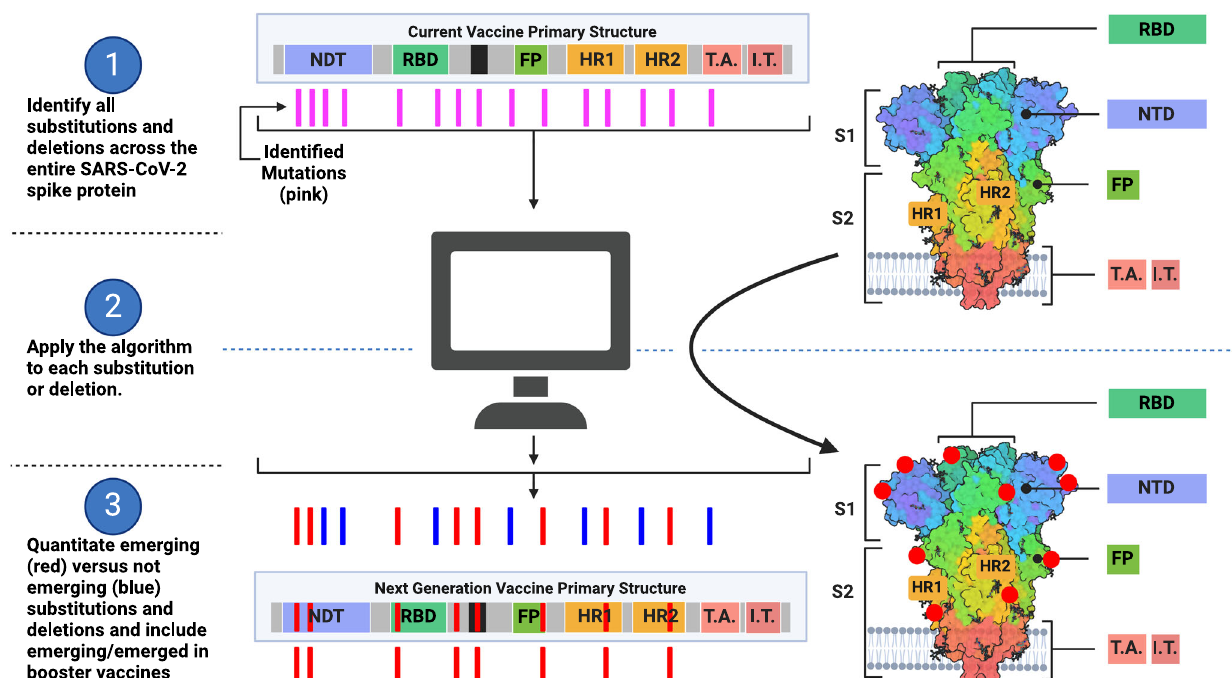
Fig. 7 Applying the Algorithm to Vaccine Design. The model displays how the algorithm would lead to the design of next-generation vaccines based on the S gene. Part one of the model identi fi es all SARS-CoV-2 variants or genomic mutations and spike amino acid substitutions and deletions (represented as pink lines) based on the worldwide sequence databases GISAID and GenBank. The current vaccine design as it translates into proteins is depicted in the top center and top right. Part two of the model will apply the quantitative analysis and algorithm described in this report to each of the protein changes identi fi ed in part one. The quantitative analysis determines emergence via logarithmic transformation of prevalence and Pearson ’ s correlation. The algorithm then applies criteria to the quantitative analysis and previous months prevalence for determining which changes are likely to be in the majority of SARS-CoV-2 for incorporation in the next-generation vaccine. Part three of the model determines which substitutions and deletions are exponentially emerging or emerged (red lines) and which are not (blue lines). From part three, the mRNA sequence of vaccines can then incorporate the emerging and emerged mutations so that the folded protein (bottom right) will contain the protein changes (red dots) most prevalent worldwide by the time the next- generation vaccine is manufactured and administered. As a result, these substitutions and deletions will present the most appropriate epitopes of the SARS-CoV-2 spike protein to vaccine recipients. Adapted from “ An In-depth Look into the Structure of the SARS-CoV2 Spike Glycoprotein ” , by BioRender.com (2021). Created with